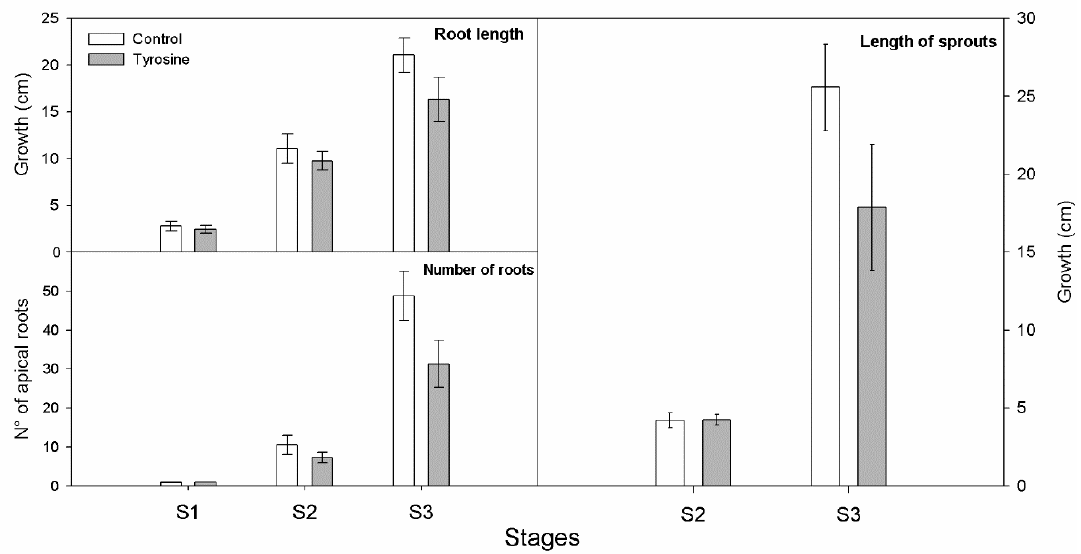
Figure 2. Effect of tyrosine treatment on root length, number of roots, and length of sprouts in V. faba at the early stages of development: S1: 3 – 4 days, S2: 8 – 9 days, and S3: 2 – 4 leaves. Bars indicate ± standard error ( n = 3). No significant differences between controls and tyrosine treatments were found, Tukey ( P < 0.05).